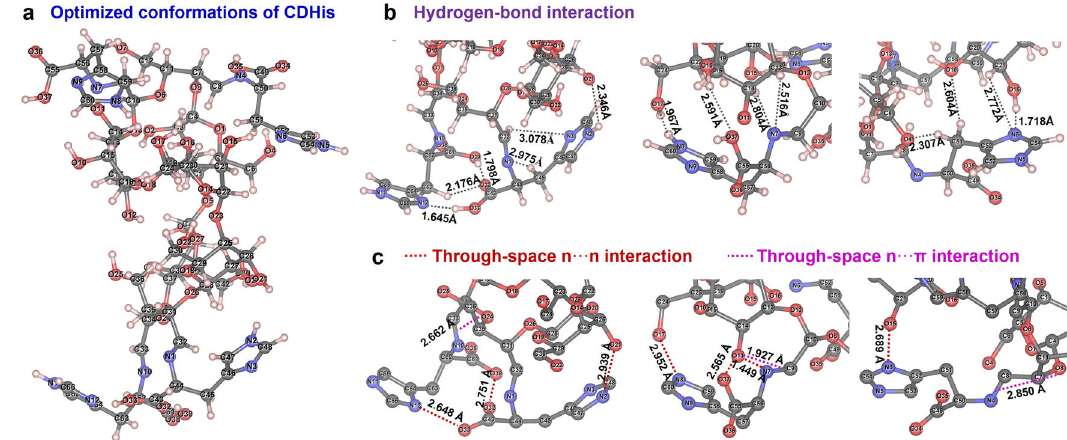
Fig. 3 | The intramolecular interactions in CDHis.a Optimized conformations of CDHis. b Hydrogen bonds interaction around His moieties. c Through-space n···n and n··· π interactions between His moieties and cyclodextrin